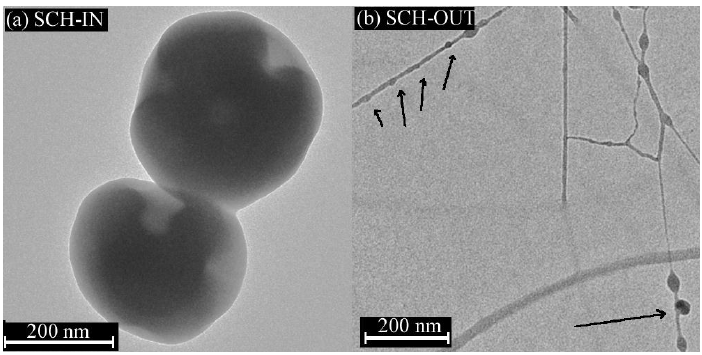
Figure 6. Transmission electron microscopy (TEM) images SCH-IN ( a ) and SCH-OUT ( b ).